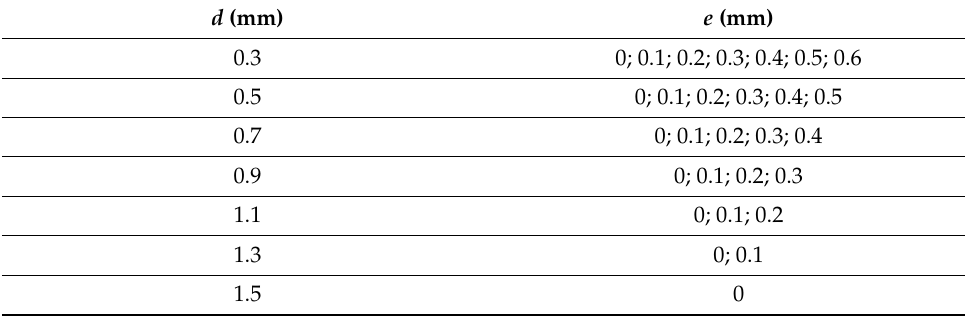
Figure 1. Parameters defining the geometry of the elliptical notched bar with an eccentric circular inner crack: ( a ) cross-section containing the crack; ( b ) longitudinal section of the bar. Table 1. Diameters and eccentricities of the circular inner crack.